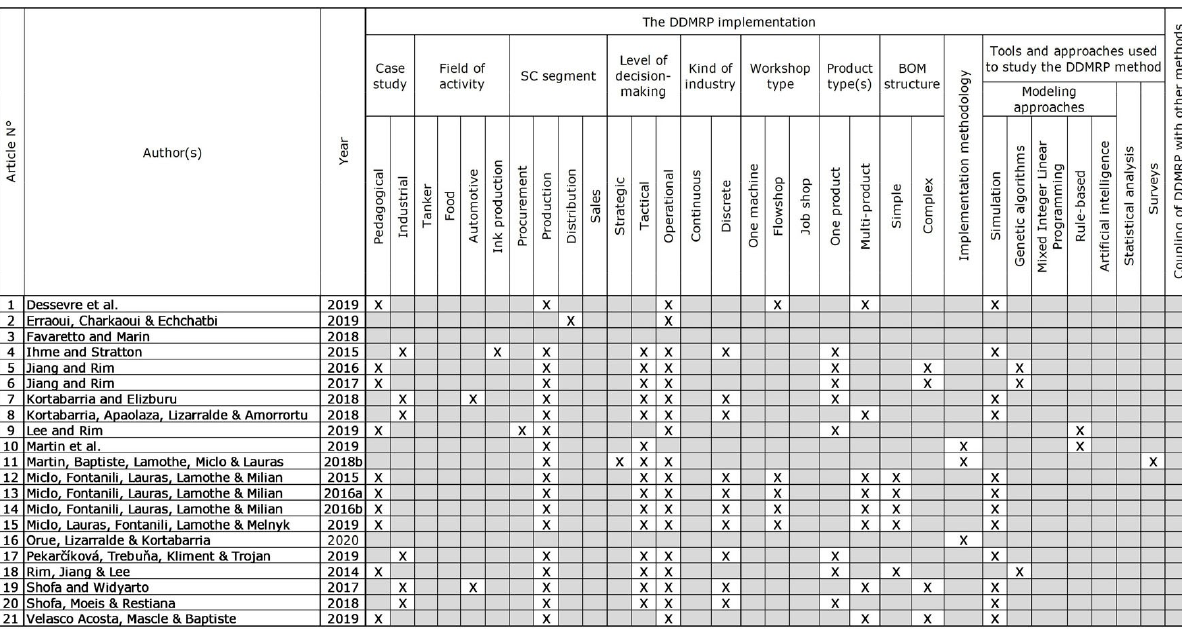
Table 2. The DDMRP implementation